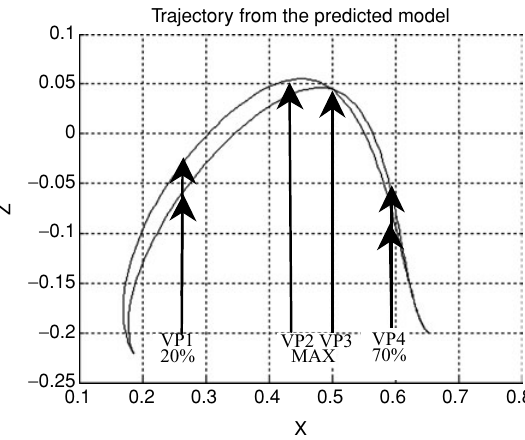
Figure 13 Via point position